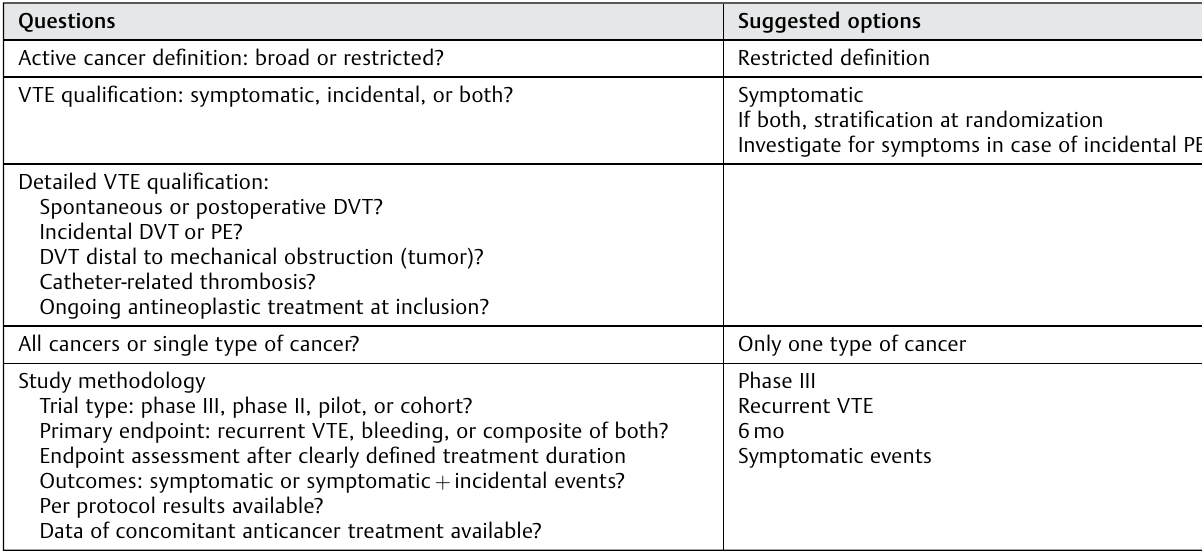
Table 3 Study features and questions relevant to the applicability of CT trial results